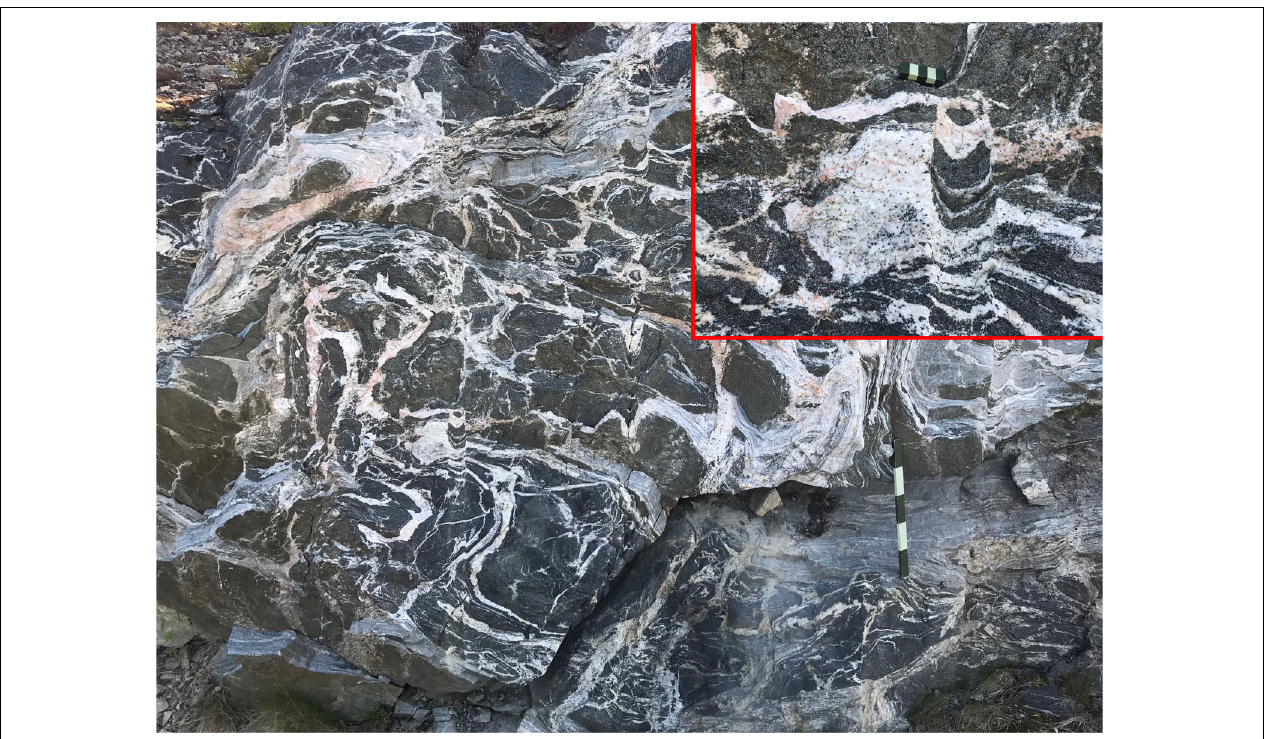
FIGURE 5 | Vein metatexite Kvaløya, northern Norway, West Troms Basement Complex. Discordant vein-like and patchy leucosomes and dikelets form an interconnected network for melt migration. Length of scale 50 cm. Inlet: peritectic hornblende formed by the melt-producing reaction occur as small black grains in leucosome. Length of scale 5